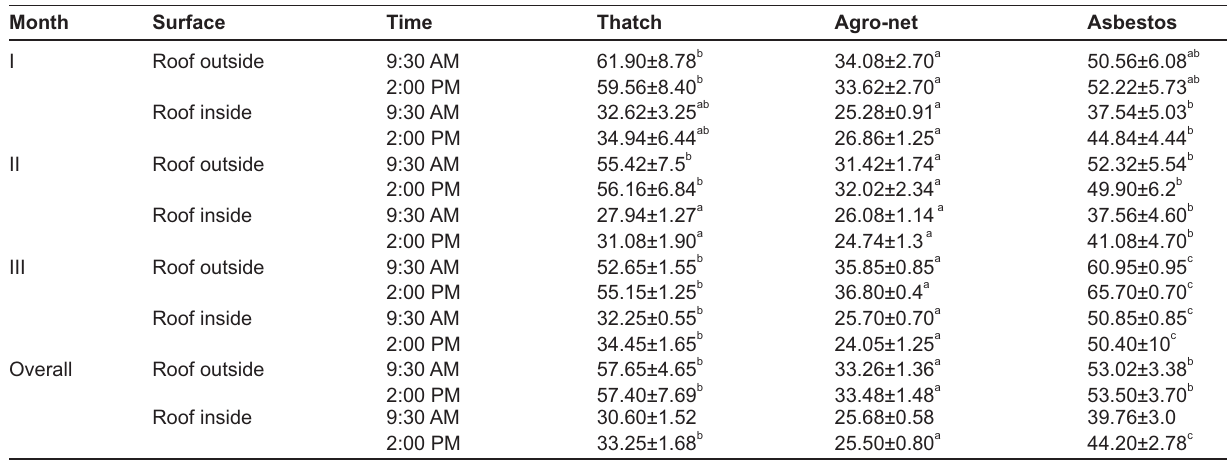
O Table-3. Surface temperature ( C) of different shade materials during rainy